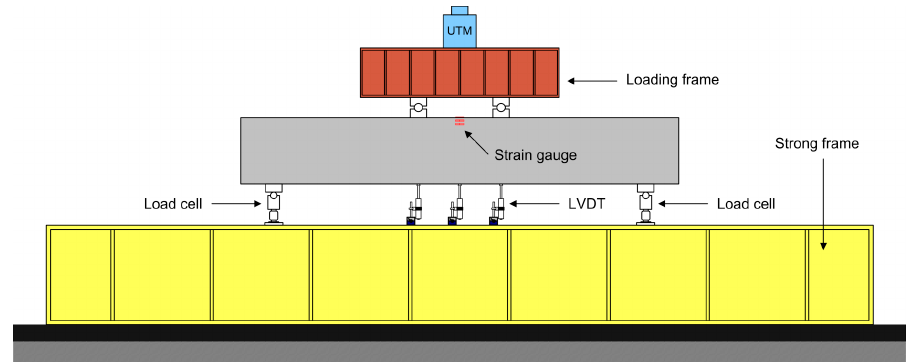
Figure 3. Test setup of a typical specimen.